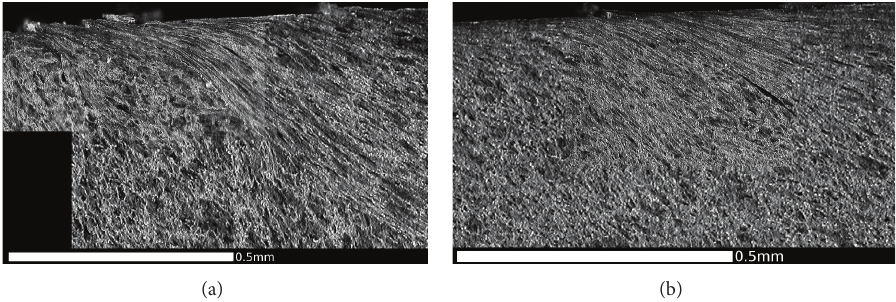
Figure 15: OM images of microstructure in the RCF band, (a) Region E1, and (b) Region E2. This region experiences high tangential forces, typically toward the centre of the tread (a) as shown in Figure 4, and these cause significant surface cracking (Figure 3). The microstructure is sheared in the same direction, and the influence extends to a depth of about 0.3 mm. Cracks are visible in this section, including two that have joined sub-surface in Region E1.